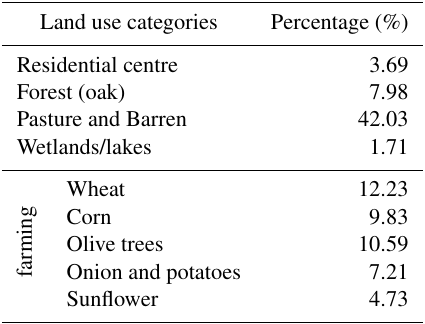
Table 1. Occupation percentages of major land covers in R’dom